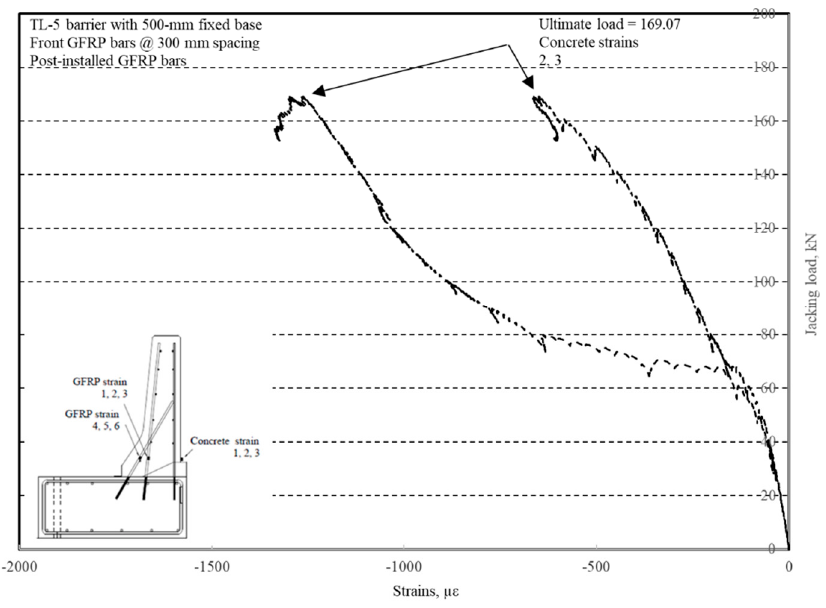
Figure 29. Specimen # 5: Load vs. concrete strain history.